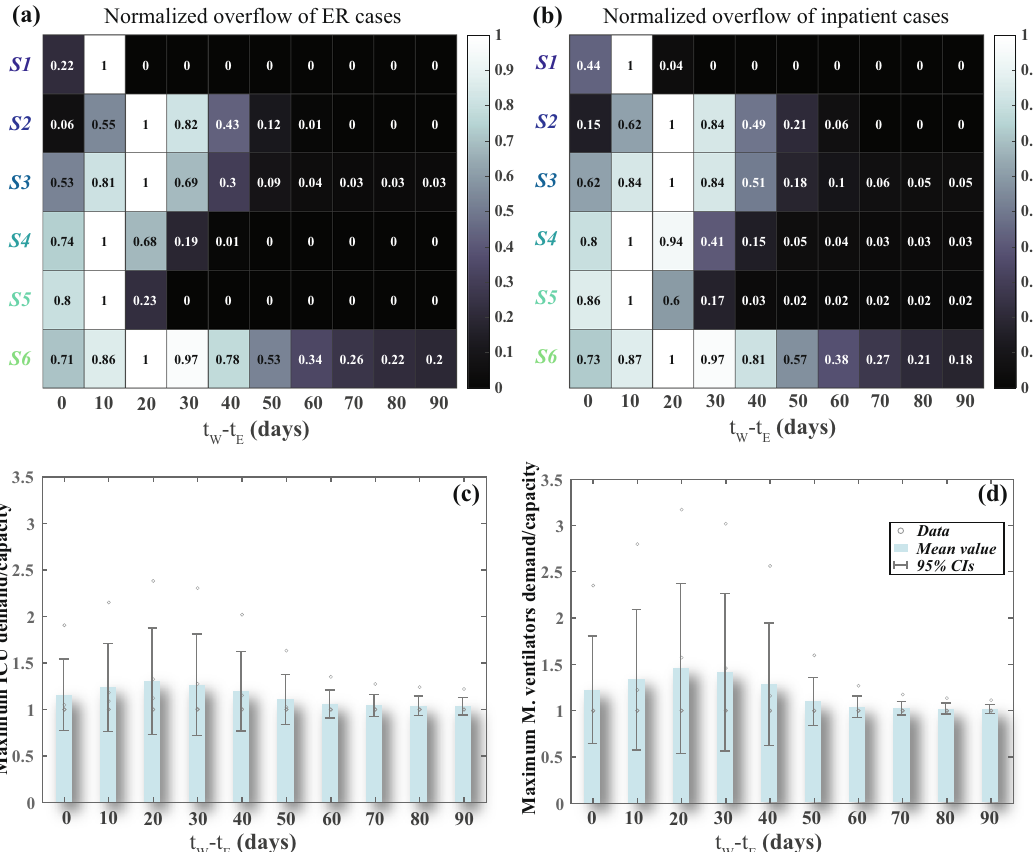
Fig. 3 The effect of hazard relative occurrence time on hospital demand to capacity ratio. a the normalized ratio of patients who leave the ER room without seeing a physician and b the normalized ratio of patients who require hospital admission and due to the higher demand for the healthcare system, they could not fi nd a bed. The relationships between the ratio of maximum patient demand to the capacity and relative time between the wild fi re occurrence, t W , and disease outbreak, t E , including c the patients who are supposed to stay in the ICU and d patients who require a mechanical ventilator. These relationships highlighted using the mean value and 95% con fi dence intervals (CIs) of the sample size ( n ) that represents six different disease spread rates obtained from Hubei, China (S1), Iran (S2), Italy (S3), Spain (S4), Germany (S5), and the U.S.